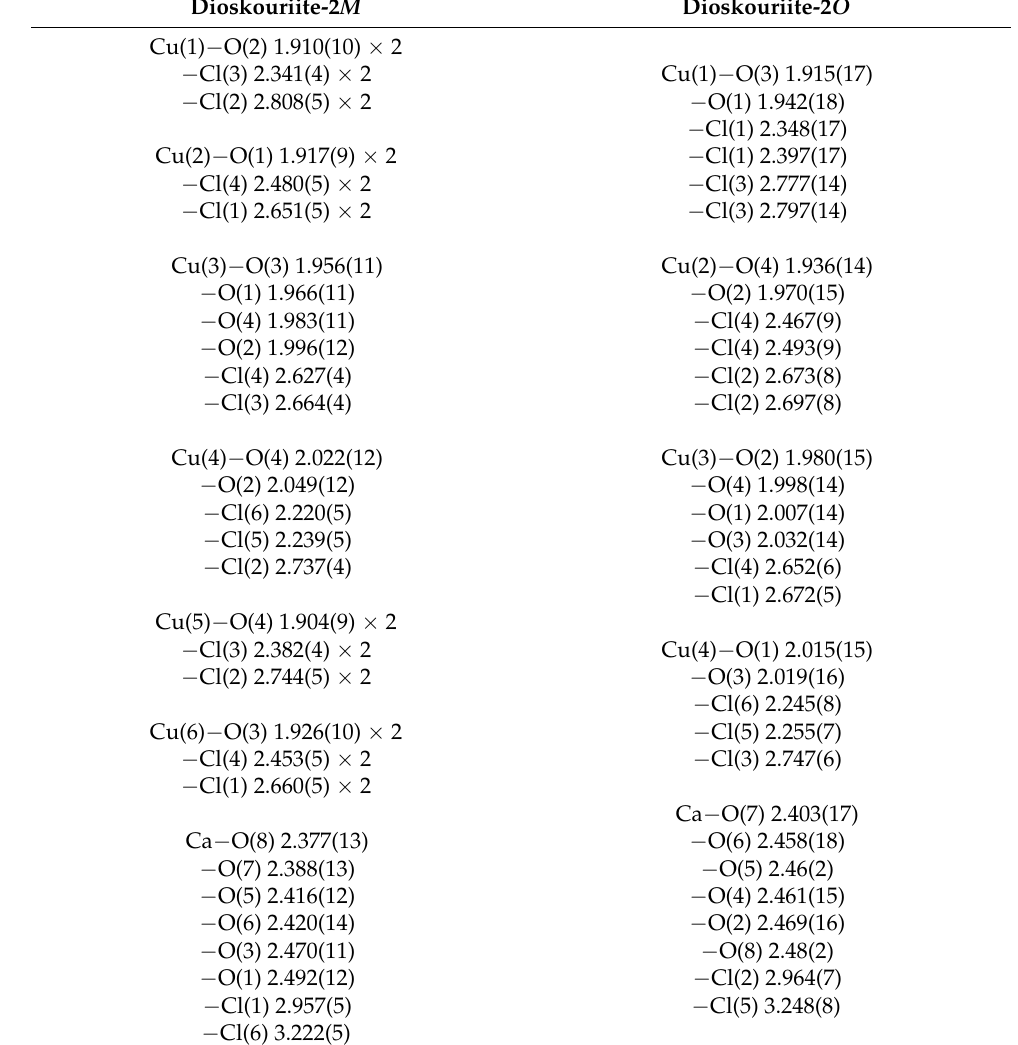
Table 6. Selected interatomic distances (Å) in the structures of dioskouriite-2 M and dioskouriite-2 O .